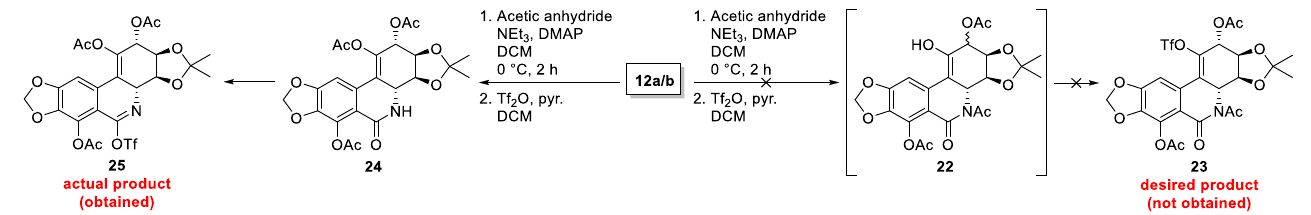
served because of potential competition between the C-1 enol and the ring-B lactam. The mix-